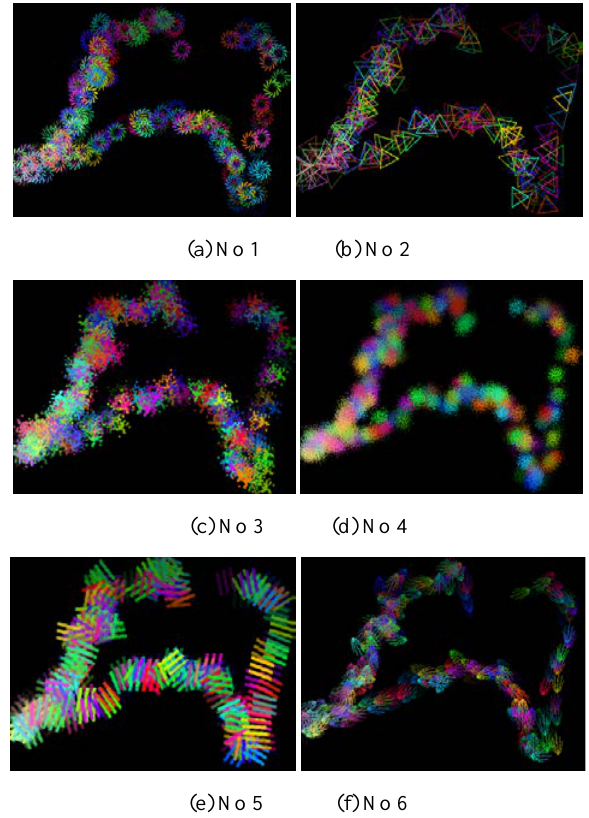
Figure 7. Rendering results with various step sizes